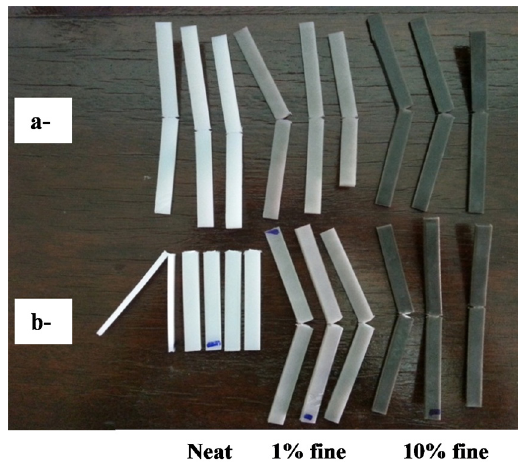
Figure 9. Specimens after the impact test: unexposed (a) and after 33 days UV irradiation (b).